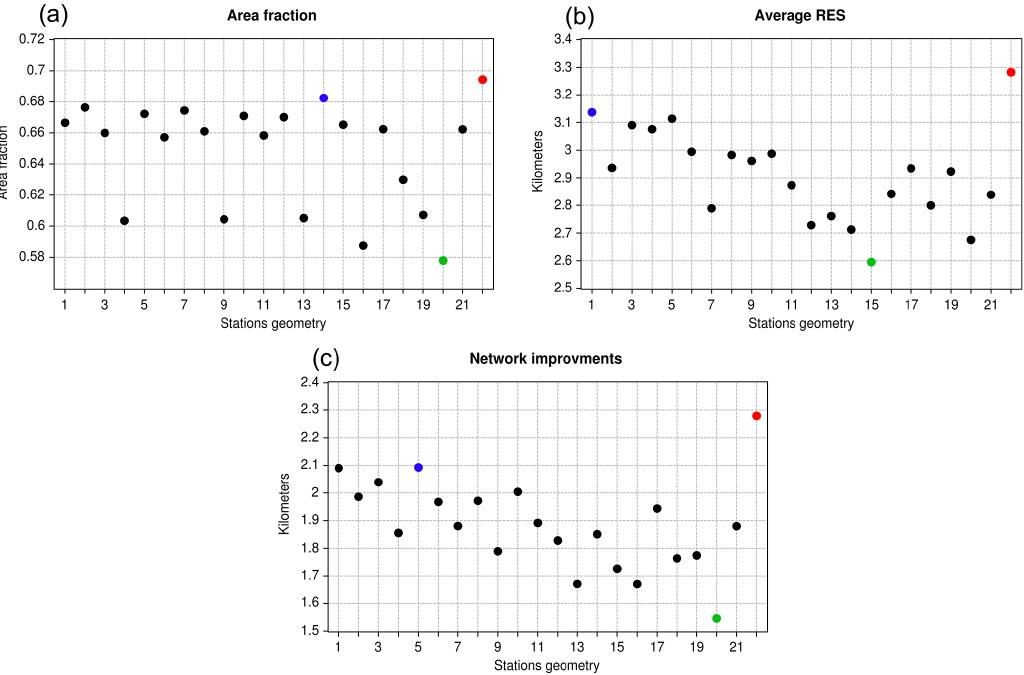
Figure 5. (a) A RES , (b) RES and (c) I (cid:0) A RES , RES (cid:1) as function of OBS / H geometry of Fig. 4; station geometry 22 refers to that assuming seven OBS / H (Fig.